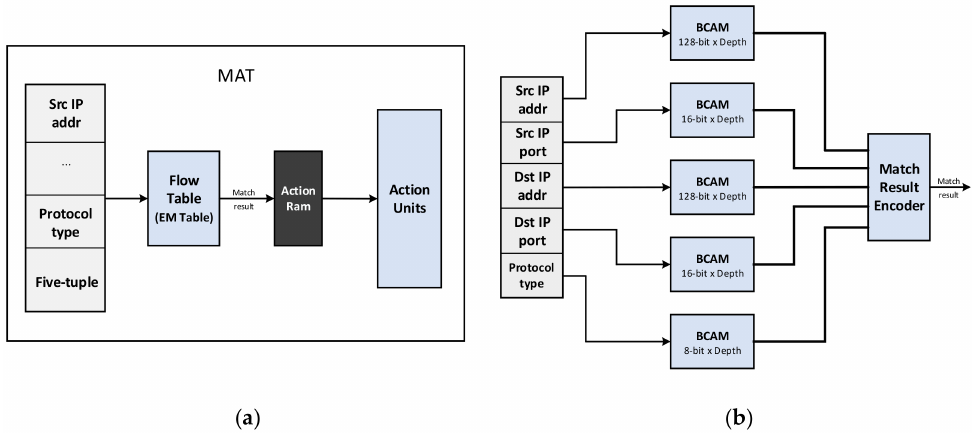
Figure 16. Design of MAT and flow table in EM rule table OFU. ( a ) Design overview of MAT; ( b ) concatenating design of flow table based on multiple BCAMs.